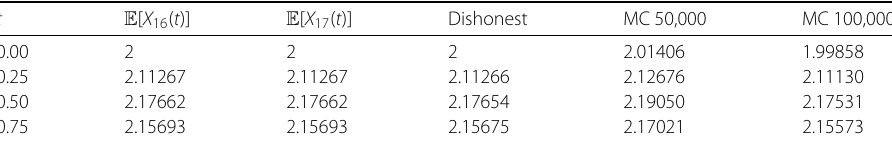
Table 12 Approximation of the expectation of the solution stochastic process. Example 4.4, assuming independent initial conditions